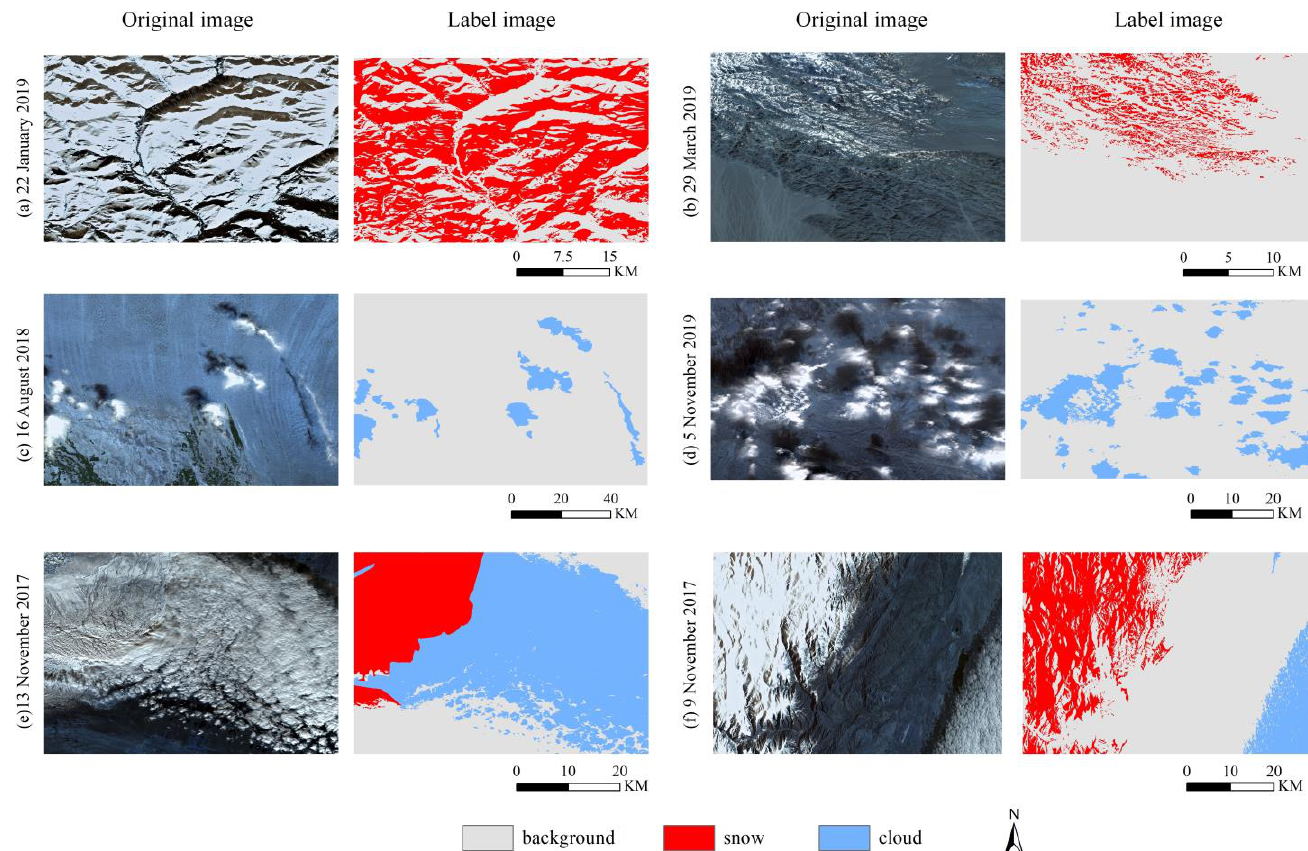
Figure 1. Examples of labeled dataset. Subfigures ( a – f ) are eight pairs of cloud and snow labels on different dates, each with remote sensing image on the left and corresponding labeled image on the right.